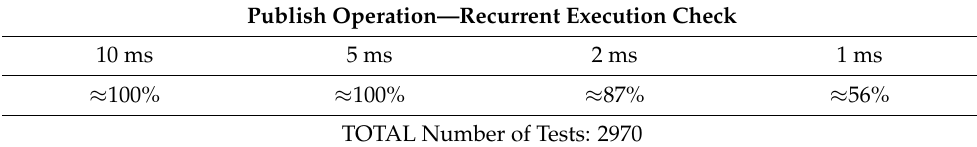
Table 6. OPC UA Control Node—Native Linux OS—Publish